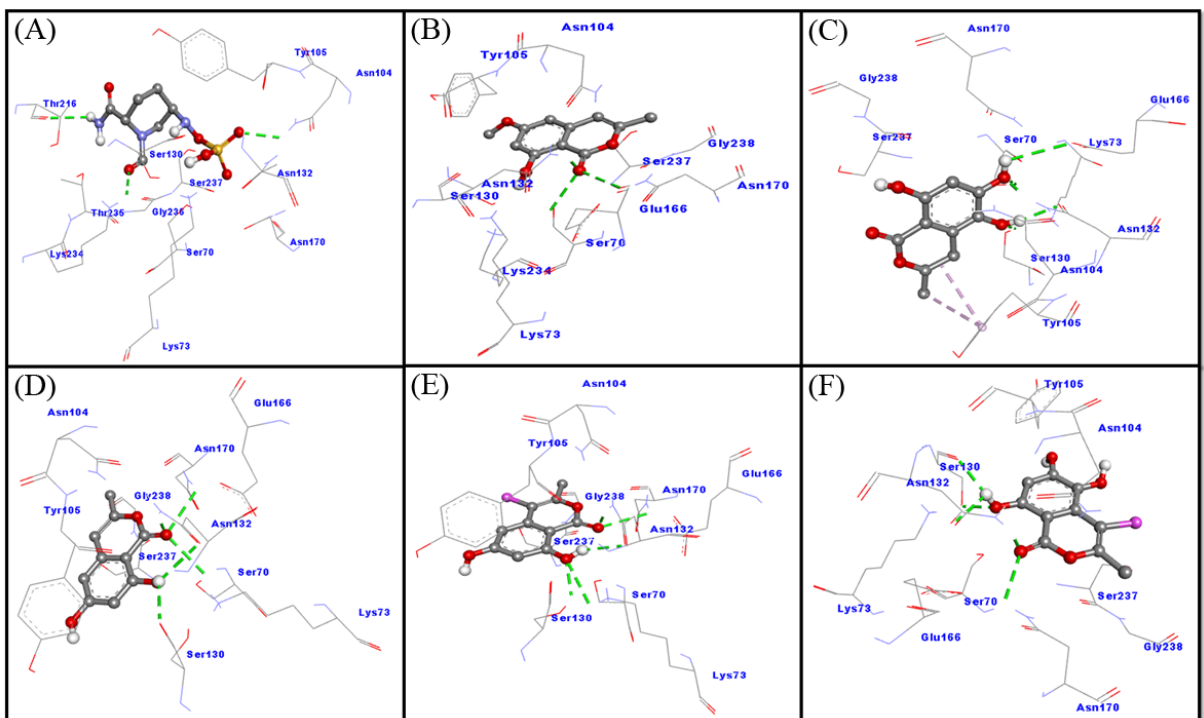
Figure 4. Binding mode of the ligands: avibactam ( A ); Compound 1 ( B ); compound 2 ( C ); compound 3 ( D ); and compound 4 ( E ) and compound 5 ( F ) inside the active site of CTX-M-15.